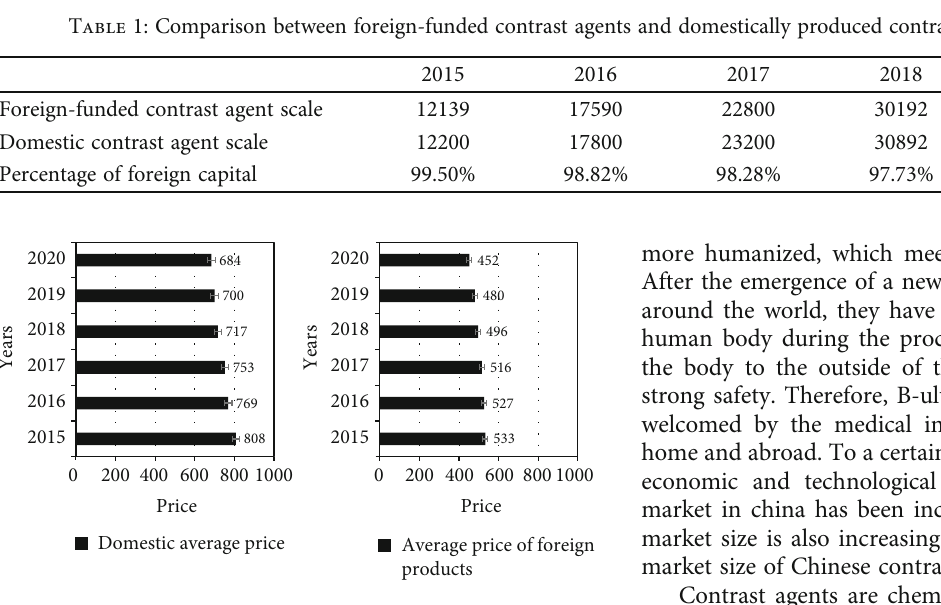
Figure 7: Product prices of China ’ s ultrasound contrast agent industry in recent